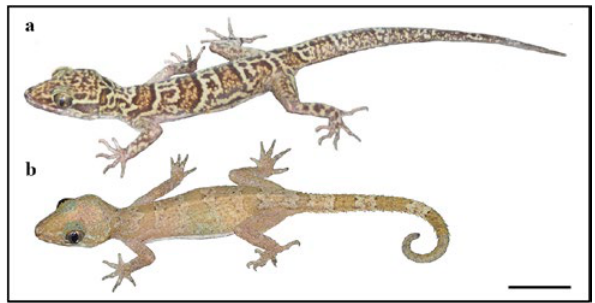
Fig. 1. General characteristic of male Cyrtodactylus kunyai (a) and female C. interdigitalis (b) (scale bar = 2